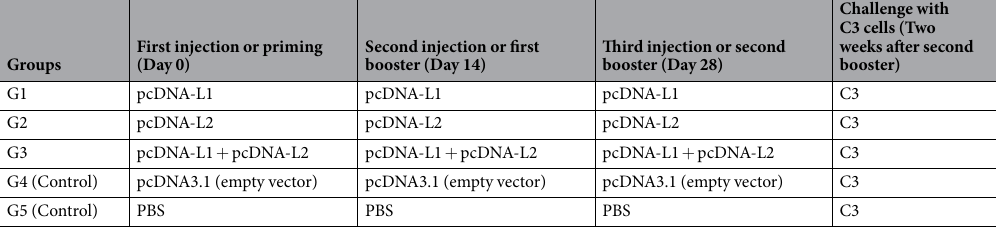
Table 16. Immunization program for in vivo